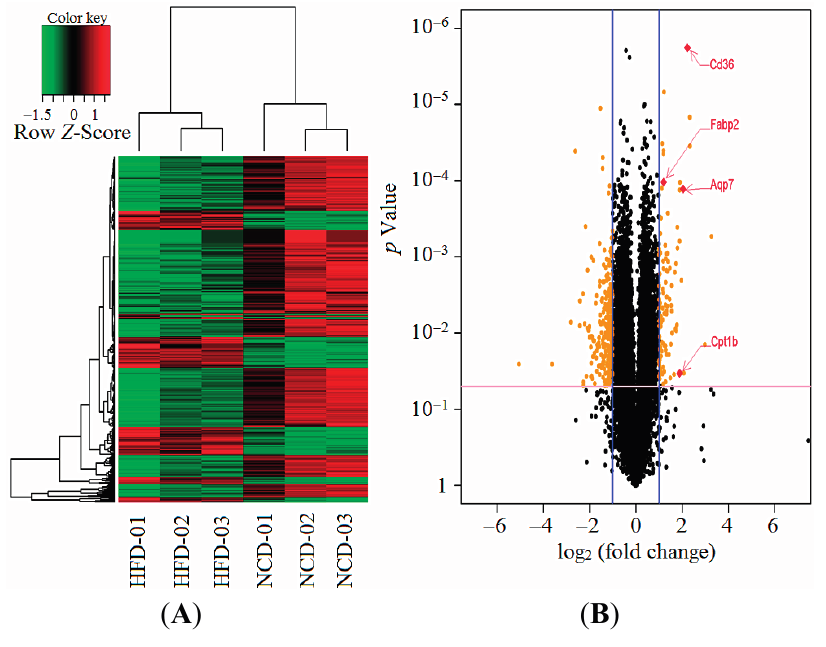
Figure 4. Gene array data analysis of the offspring between the high-fat diet and normal chow diet groups. ( A ) Heatmap diagram: this diagram illustrates the differential expression of hepatic mRNAs in the high-fat diet ( n = 3) compared with the normal chow diet offspring ( n = 3). The tree was based on the log transformation of the normalised probe signal 2 intensity using hierarchical clustering. The hierarchical clustering was based on 380 differentially expressed mRNAs; the expression levels were differentially expressed in the high-fat diet group, with red representing increased expression and green representing decreased expression; of the fold change in each gene’s ( B ) The Volcano Plot graphs: this graph shows the log 2 expression between the two group and its p value from the t -test. The blue lines indicate that the fold change in the gene expression threshold is 2. The pink line indicates that the p value of the t -test threshold is 0.05. There were four genes, which showed significantly different expression between the two groups, in the peroxisome proliferator-activated receptor (PPAR) signaling pathway. Aqp7, aquaporin 7; Cpt1b, carnitine palmitoyltransferase 1b; Fabp2, fatty acid binding protein 2; HFD, high-fat diet; NCD, normal chow